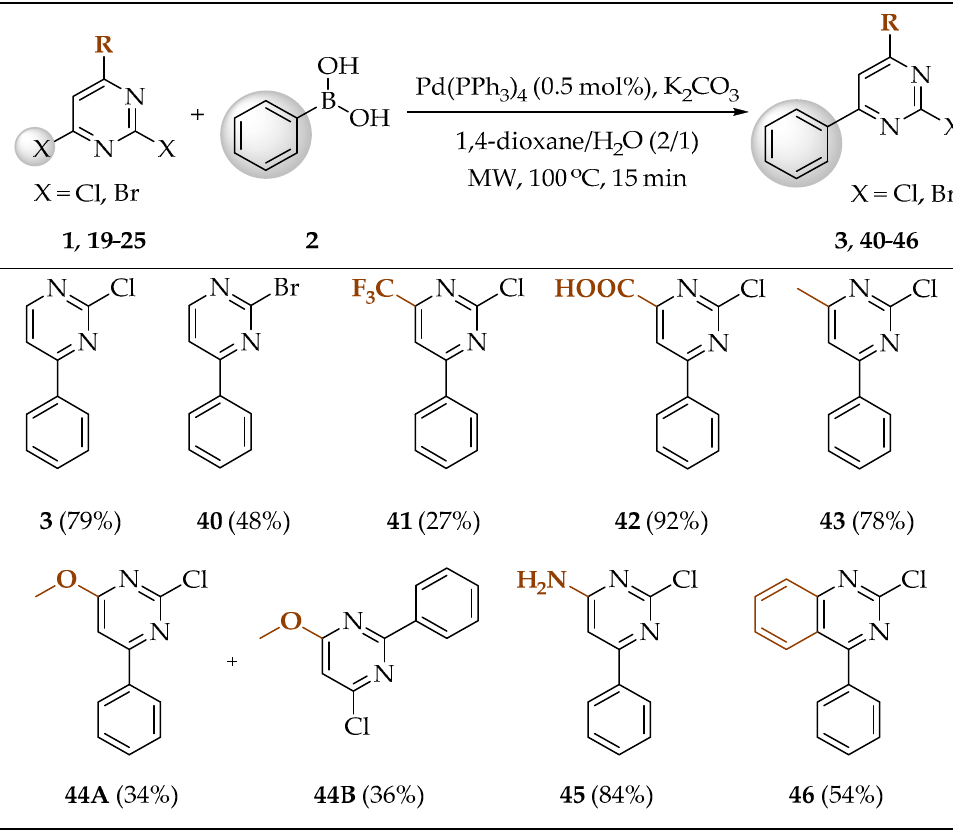
Table 7. Microwave-assisted Pd(PPh 3 ) 4 -catalyzed Suzuki coupling of 2,4-dihalogenopyrimidines with 2 .